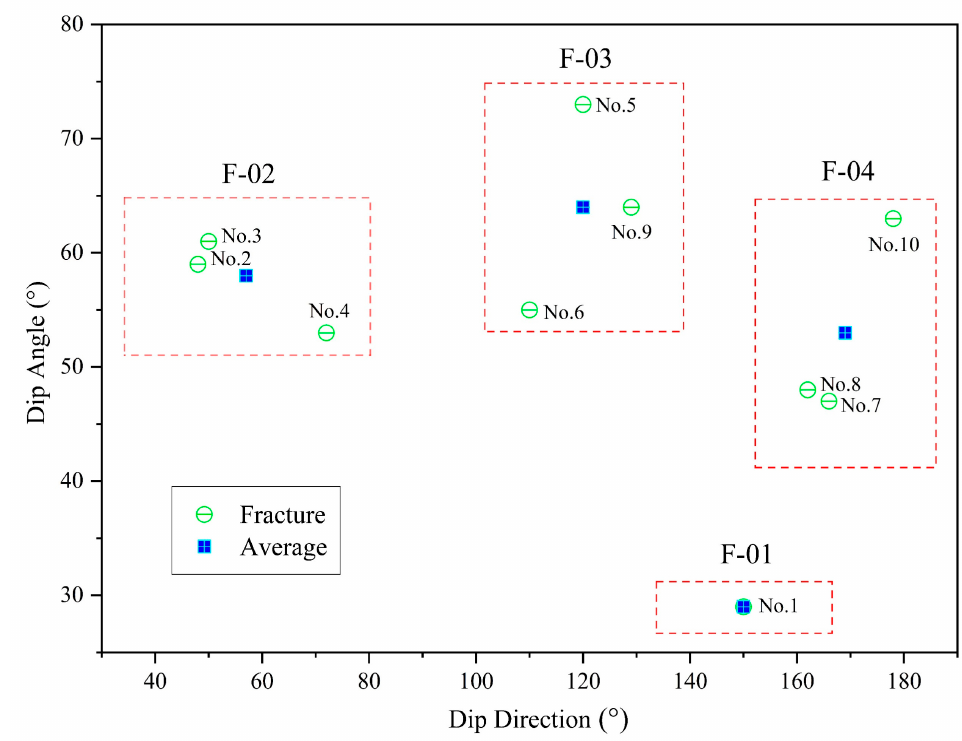
Figure 10. Statistical diagram of fracture classification. Table 7. Calculation statistics of fracture equivalent permeability coefficient in the corresponding test section.